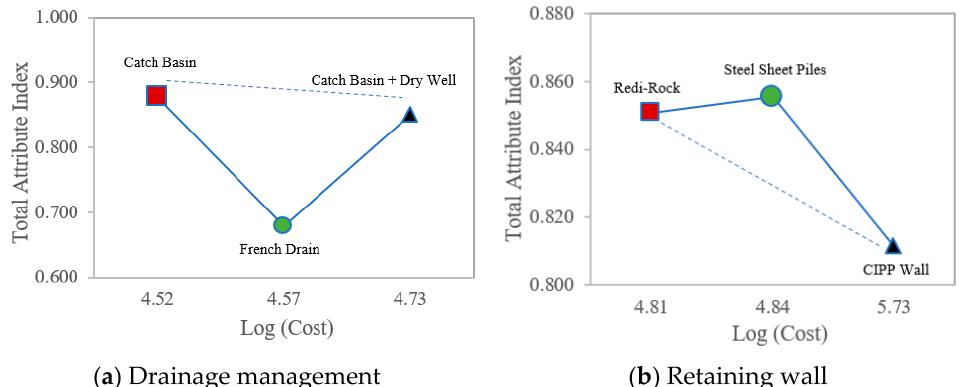
Figure 6. Final alternative comparison.